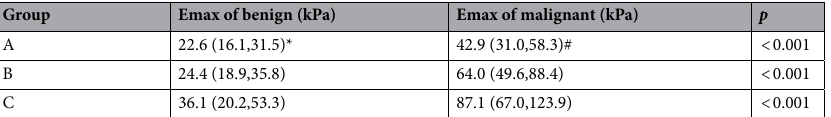
Table 2. Emax values of benign and malignant thyroid nodules in each group. Values are presented as the median (interquartile range). *indicates that the comparison of Emax values among the three groups had statistical significance for benign nodules ( p = 0.03); # indicates that the comparison of Emax values among the three groups had statistical significance for malignant nodules ( p <